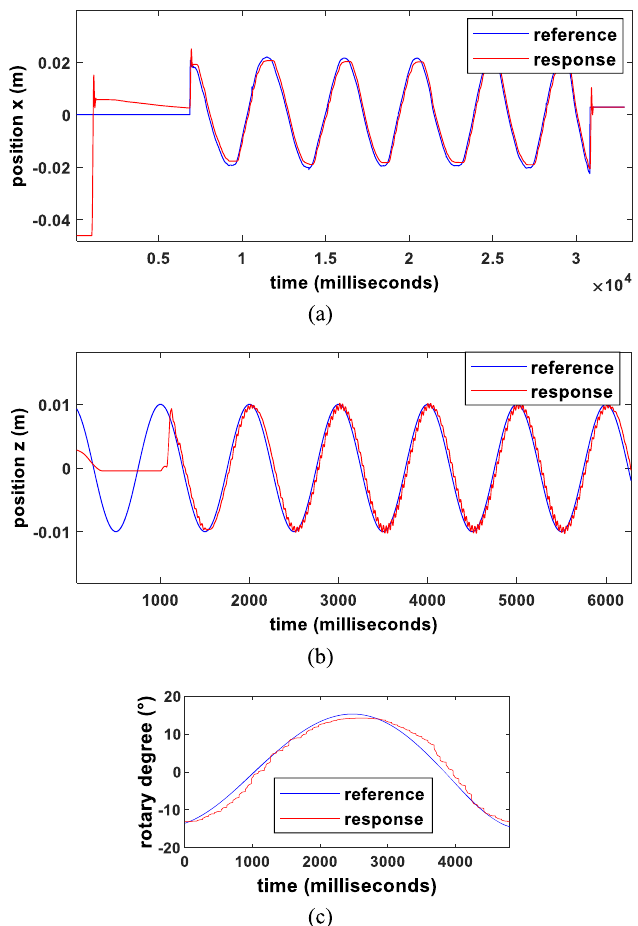
Fig. 2. Evaluation of the kinesthetic platform. (a) on x -axis horizontal motion; (b) on z -axis vertical motion; (c) on rotary motion around y